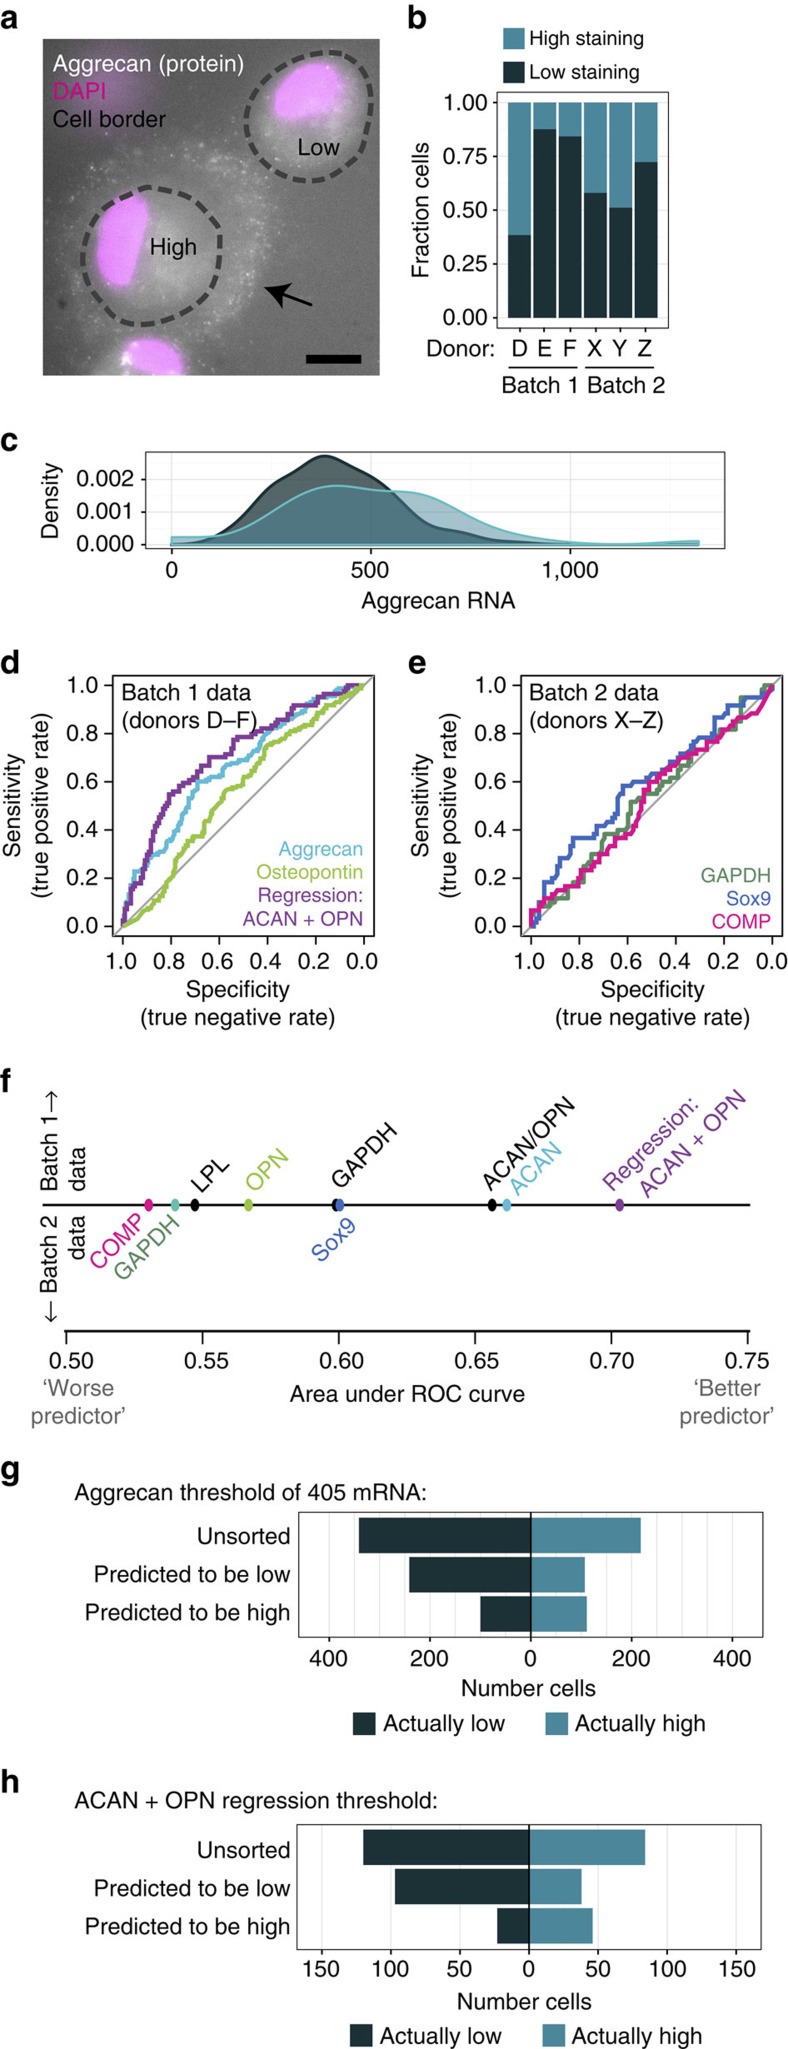
Marker gene expression is a poor predictor of cartilage-like matrix production in individual MSCs.(a) Aggrecan core protein identified by immunostaining of MSCs showing high or low cartilage-like matrix formation after 7 days of 3D culture with TGFβ. Scale bar=10 μm. (b) Fraction of cells classified as high- or low-performing based on aggrecan protein staining (cells/donor: D: 78, E: 89, F: 51, X: 62, Y: 43, Z: 47). (c) Distribution of aggrecan copy number in high- and low-performing MSC populations; probability density curve for Donor E shown (n=153 cells). (d,e) Receiver operating characteristic curves using individual gene expression and regression analysis on combinations of genes from batch 1 (d) and individual gene expression from batch 2 genes (e) to distinguish between high- and low-performing MSCs (cells/donor: D: 132, E: 153, F: 122, X: 57, Y: 42, Z: 47). (f) Summary graph of area under the curve of receiver operating characteristic curves for individual gene expression, gene expression ratios, and regression analysis of combinations of gene. (g,h) Simulated sorting of MSCs into anticipated high- and low-performing cells, using the optimized threshold of 405 aggrecan mRNA copies (g) and the optimized threshold from the ACAN+OPN regression (h).